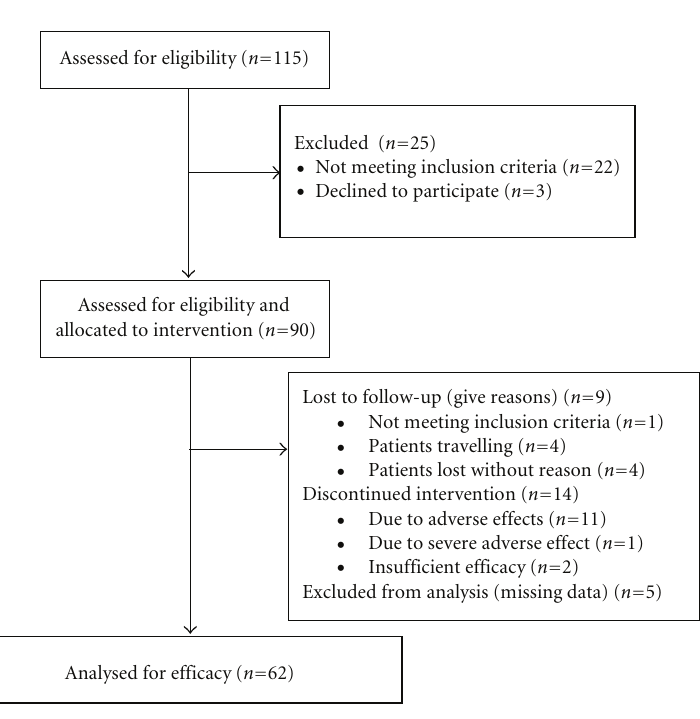
Figure 1: Patients flow chart.